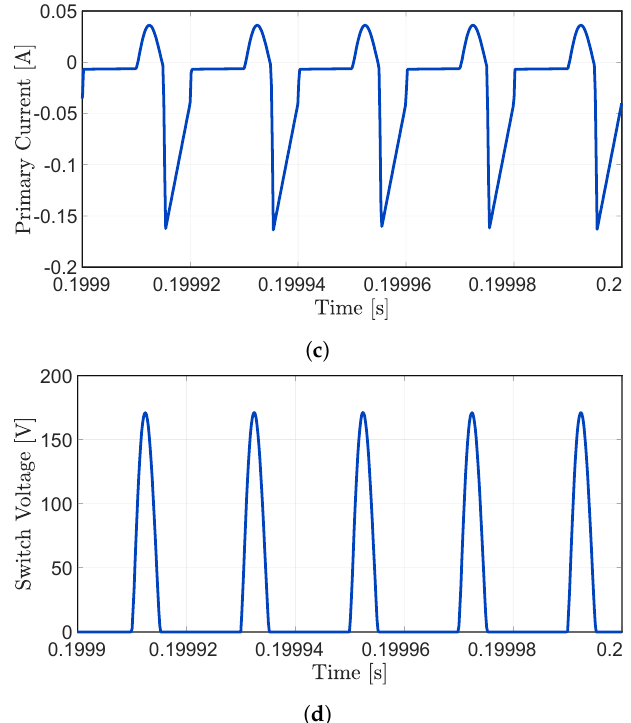
Figure 8. ( a ) Cell voltages vs. time of the circuit; ( b ) primary and secondary voltages vs. time; ( c ) primary current vs. time of the circuit in the steady state; ( d ) switch voltage vs. time of the circuit in cells in the steady state.